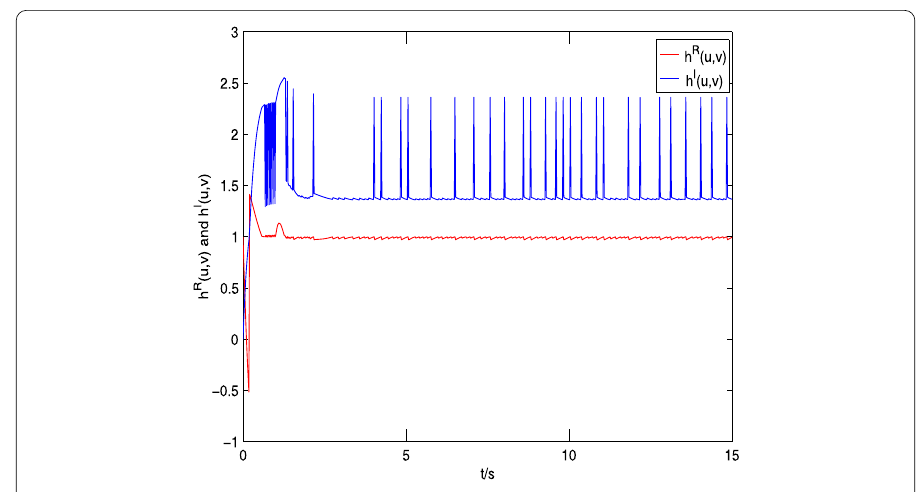
Figure 1 Time responses of the real part and imaginary part of h ( w ) in Example